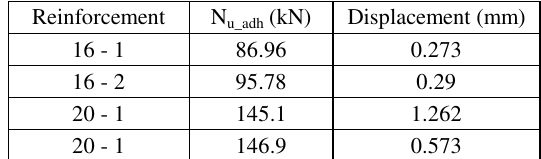
Table 4. N u_adh values and